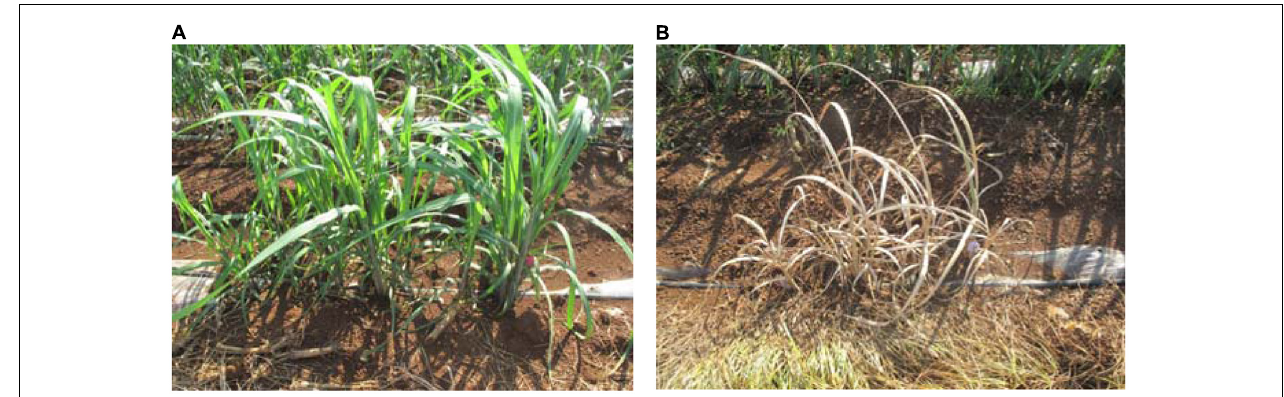
FIGURE 7 | Roundup tolerance testing in field trials. (A) Transgenic lines grew healthy 10 days after sprayed by 0.2% Roundup; (B) Control lines totally died off 10 days after sprayed by 0.2%